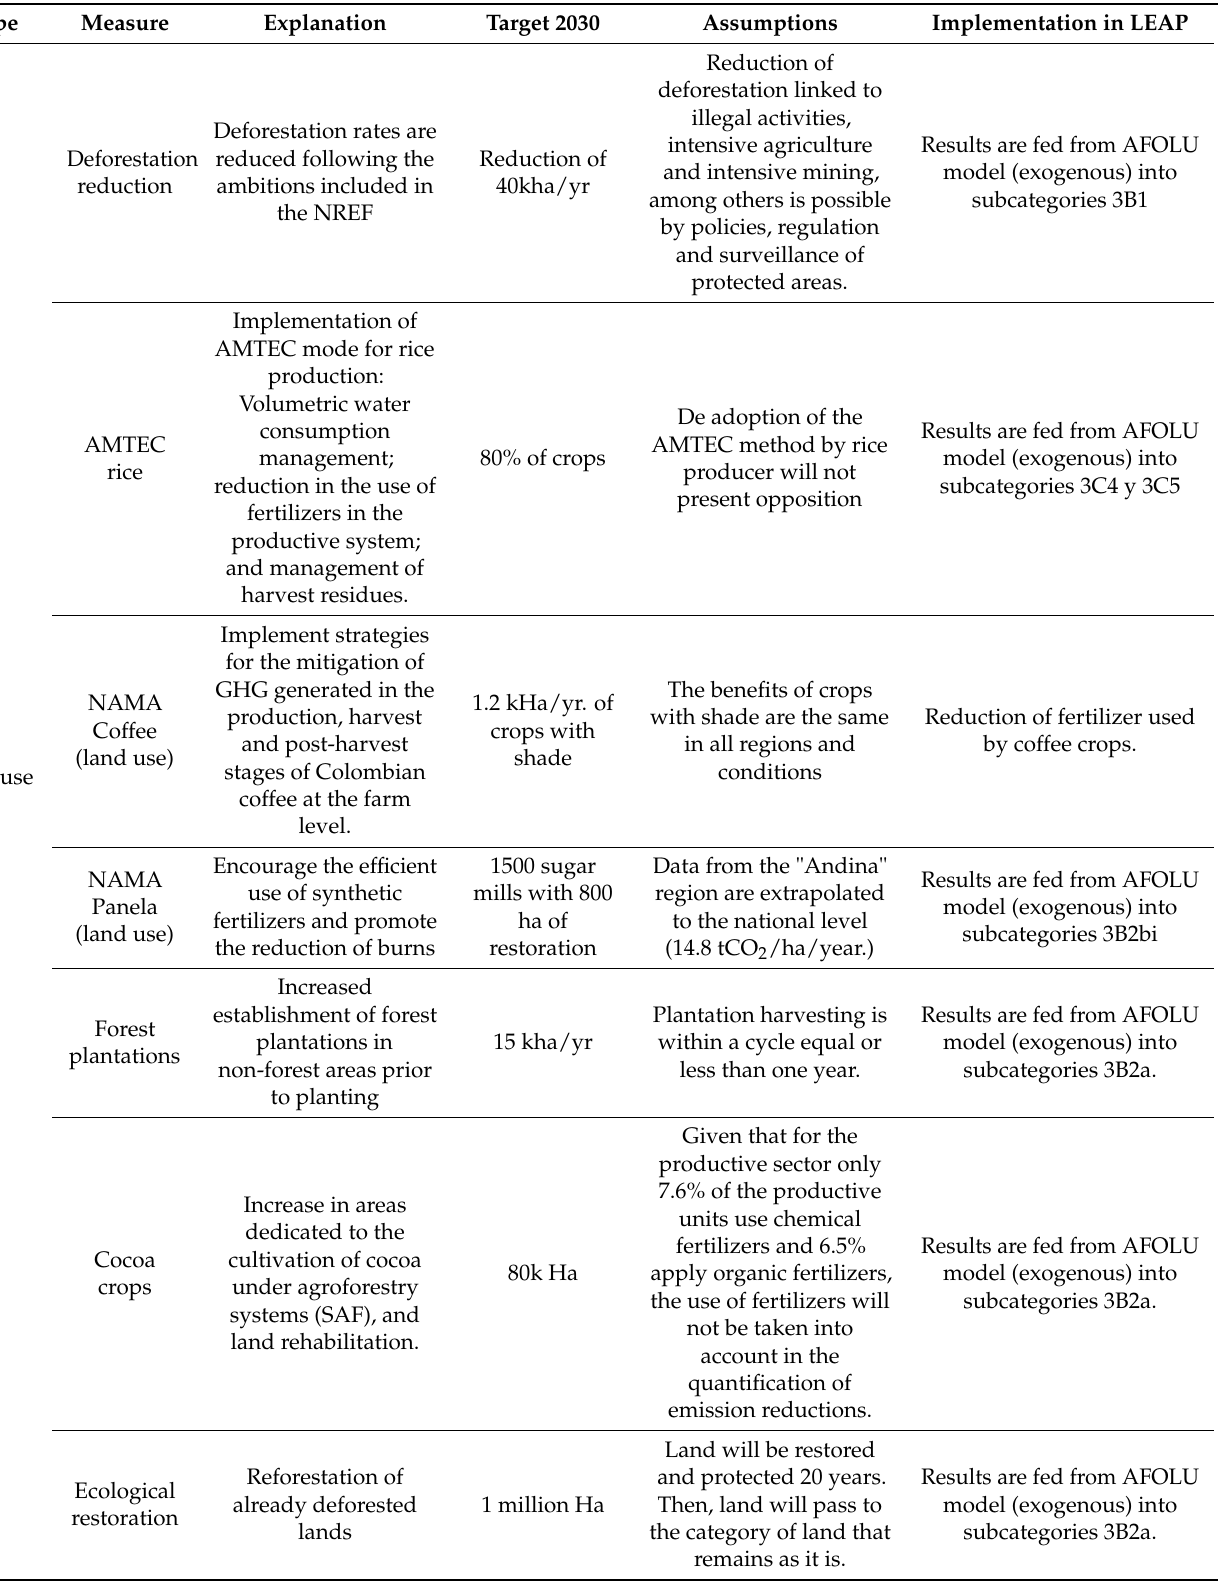
Table A6. Mitigation actions of Waste sector included in the mitigation